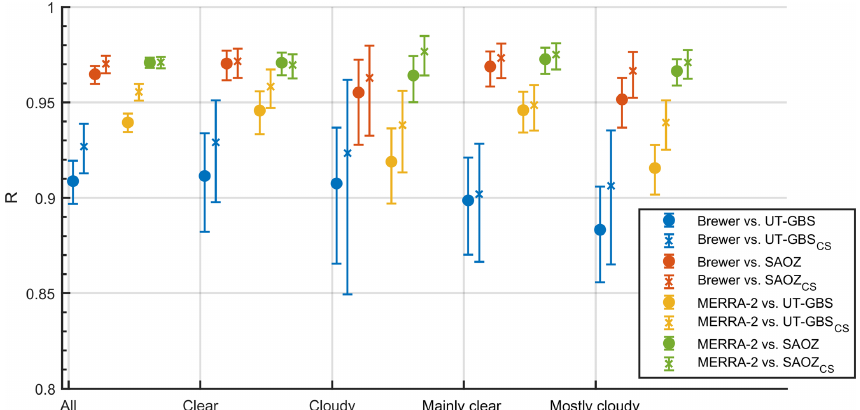
Figure 8. Correlation coefficients ( R ) of pairs of measured and modelled total column ozone datasets. The comparisons with UT-GBS or SAOZ TCO datasets are shown by circles, and those with cloud-screened TCO datasets (UT-GBS CS or SAOZ CS ) are shown by crosses. The error bars are the 95% confidence interval for each coefficient.